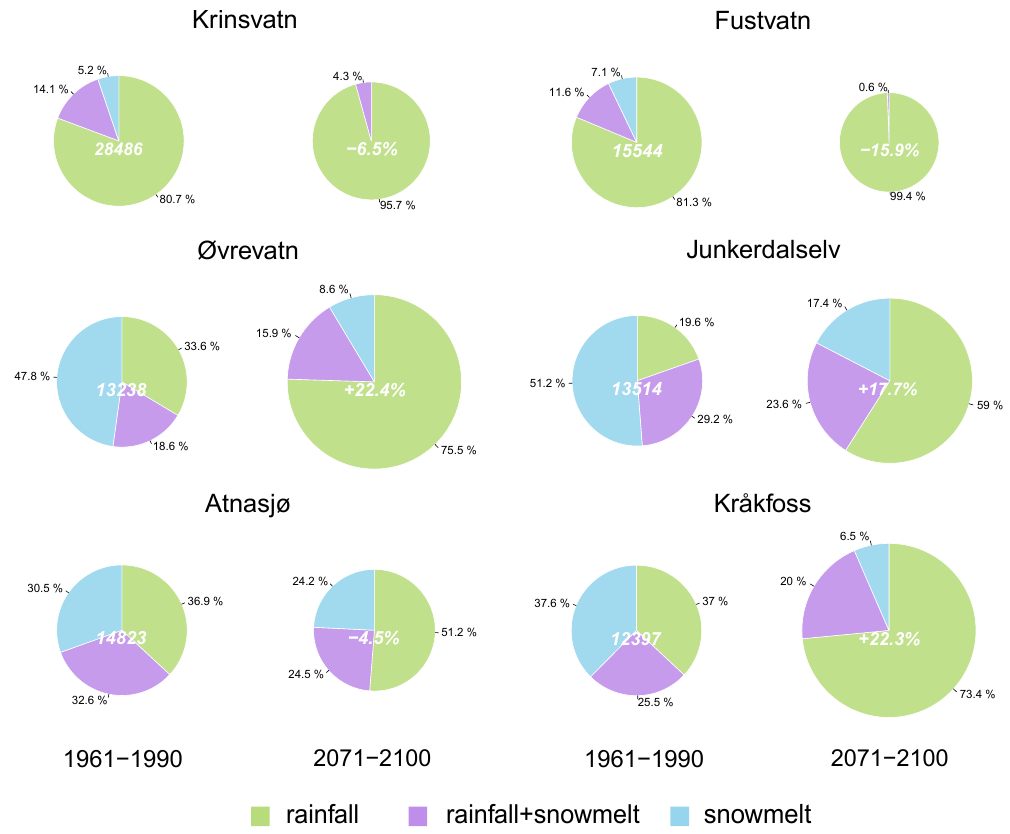
Figure 6. Percentage of POT events according to their FGPs in relation to the total number of events for the reference (left pie charts) and future periods (right pie charts) derived by all ensemble realizations. The diameter of the pie charts for the future period indicates the direction of change in the total number of events. Total numbers of events for the reference period and the percentage of change in the number of events for the future period are given by the white numbers within the pie